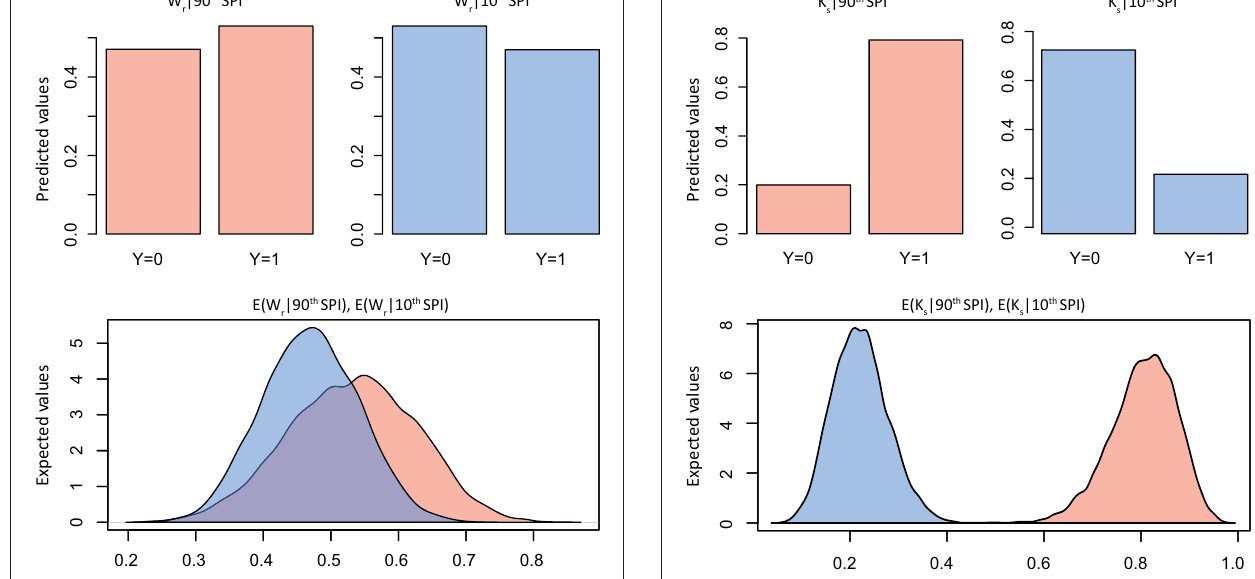
FIGURE 5 | Bayes simulation of quantities of interest. Predicted probability (bar plot) and expected probability (density plot) of presence [1] − absence [0] of K s pointer years (Y) at the 90 th (red) and 10 th (blue) percentile of the Standardized Precipitation Index (SPI). E(K s |90 th SPI), mean = 0.78( ± 0.06), 2.5% = 0.64, 97.5% = 0.89; E(K s |10 th SPI), mean = 0.24( ± 0.05), 2.5% = 0.14, 97.5% =